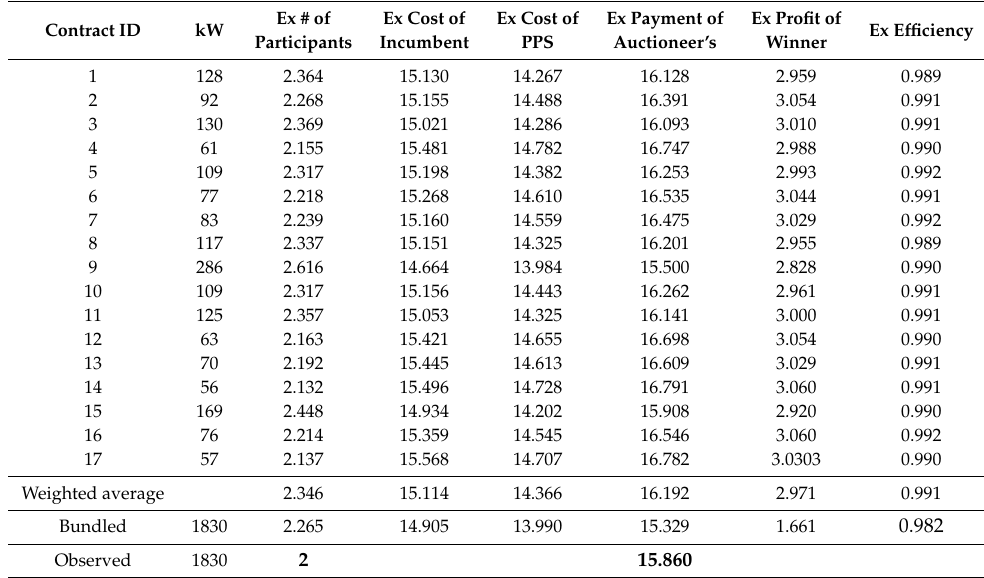
Table 4. The effect of unbundling the actual